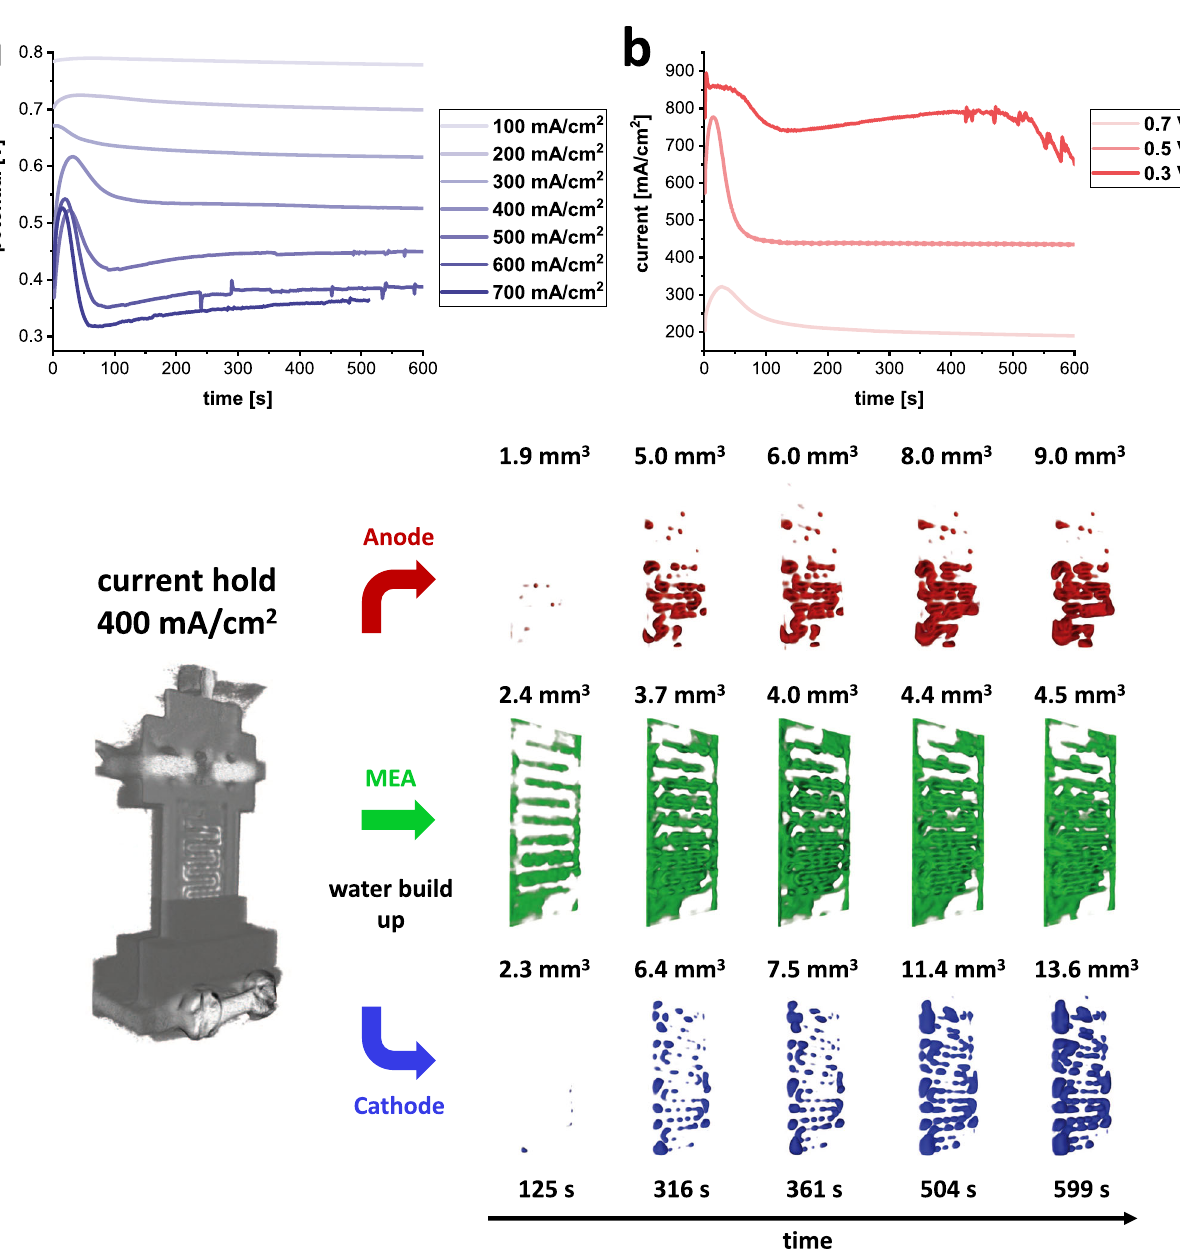
Fig. 2 Operating parameters and segmented water evolution in the single serpentine anode and cathode fl ow fi elds. a Voltage curves for current holds from 100 mA cm − 2 to 700 mA cm − 2 ; b Current curves for potential hold values 0.7, 0.5 and 0.3 V. c Water volume build up during cell operation at 400 mA cm − 2 in the anode and cathode channels. There is less water formation in the anode channel than in the cathode, with a higher concentration in the lower cell section. The cathode displays a more homogeneous water distribution with a slightly increasing water volume gradient towards the bottom of the cell. The MEA exhibits a steady accumulation of water in the fi rst 500 s before fl ow fi elds whereby the redox reaction of the diffused protons and operation. Small potential and current peaks and troughs at oxygen from the air occur on the cathode side. Accumulated higher currents are the result of an uncontrolled cell fl ooding, e.g., water on the anode side is the result of back diffusion, where at 600 mA cm − 2 current hold or at 0.3 V potential hold. water is transferred through the electrolyte from cathode to anode. At the anode side, water accumulates preferentially in the Water evolution in the anode and cathode fl ow fi elds . The lower section of the cell, whereas the cathode side shows a more generated water in the cathode (blue) and anode (red) single homogenous water build-up over the whole fl ow fi eld area. serpentine fl ow fi elds, as well as in the MEA (green), are visua- Nonetheless, the cathode side does have a slight gradient in the lised by applying a greyscale threshold to isolate the water in the water distribution, with a larger amount accumulated in the lower fl ow channels, as described in the “ Methods ” section. Figure 2c channel bends of the cell. Accumulation of water in the lower shows the 3D rendered water volumes inside both fl ow fi elds and parts of the cell is attributed to both gravitational force draining the MEA at selected time intervals for the 400 mA cm − 2 current water down through the channels, as well as the downward- hold measurement. During operation, water accumulates in both